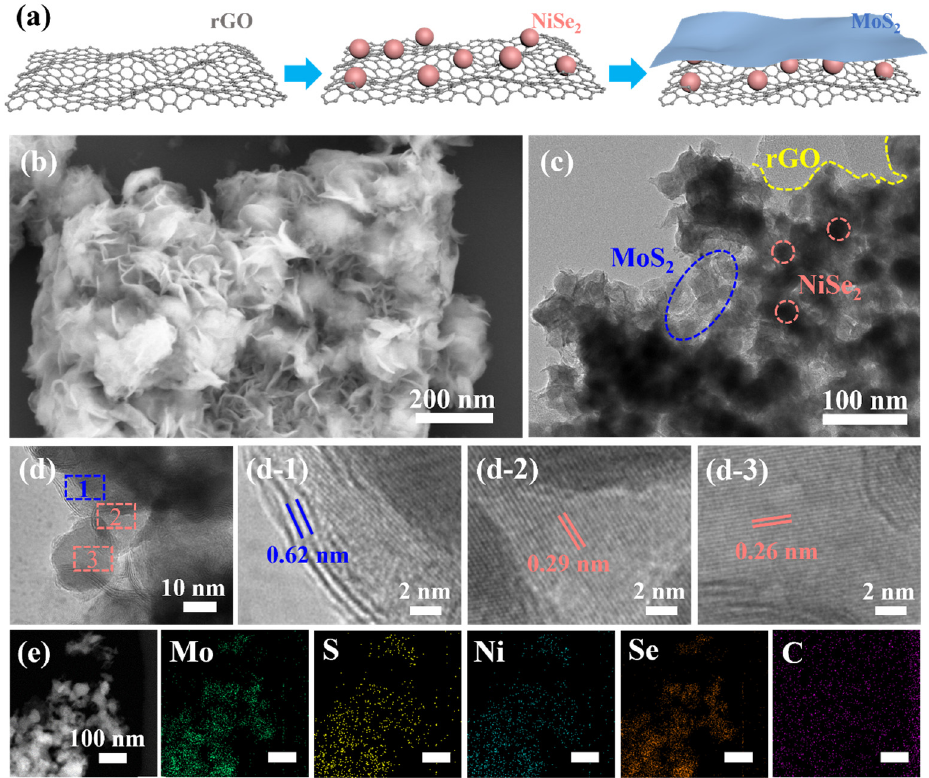
Figure 1. Structural characterizations of MoS 2 /NiSe 2 /rGO. ( a ) Schematic illustration of the MoS 2 /NiSe 2 /rGO formation process. ( b ) SEM, ( c ) TEM, ( d ) HRTEM, and ( e ) HADDF-STEM images and the corresponding element mapping of MoS 2 /NiSe 2 /rGO. ( d-1 , d-2 , d-3 ) are the local enlarge- ments of ( d ), respectively.